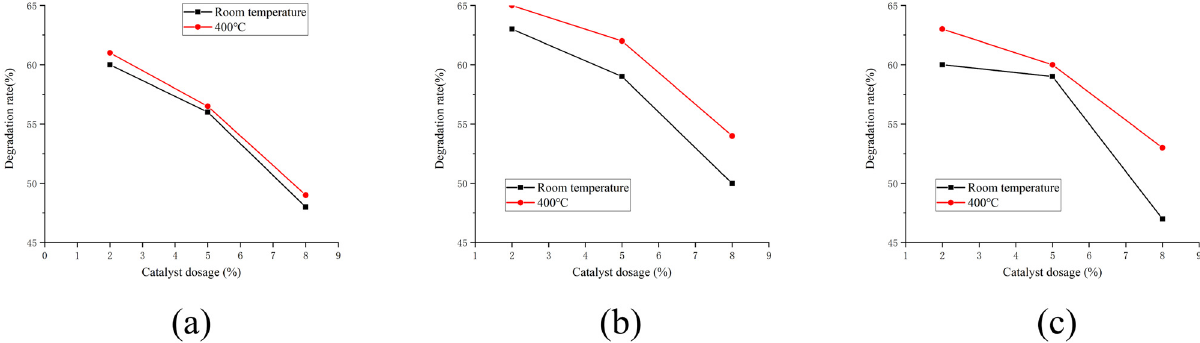
Figure 7: Comparison of photocatalytic performance of catalysts treated at di ff erent temperatures under ultraviolet light sources. ( a ) TiO 2 concrete, ( b ) CdS/TiO 2 - R400 concrete, ( c ) CdS/TiO 2 - R600 concrete.